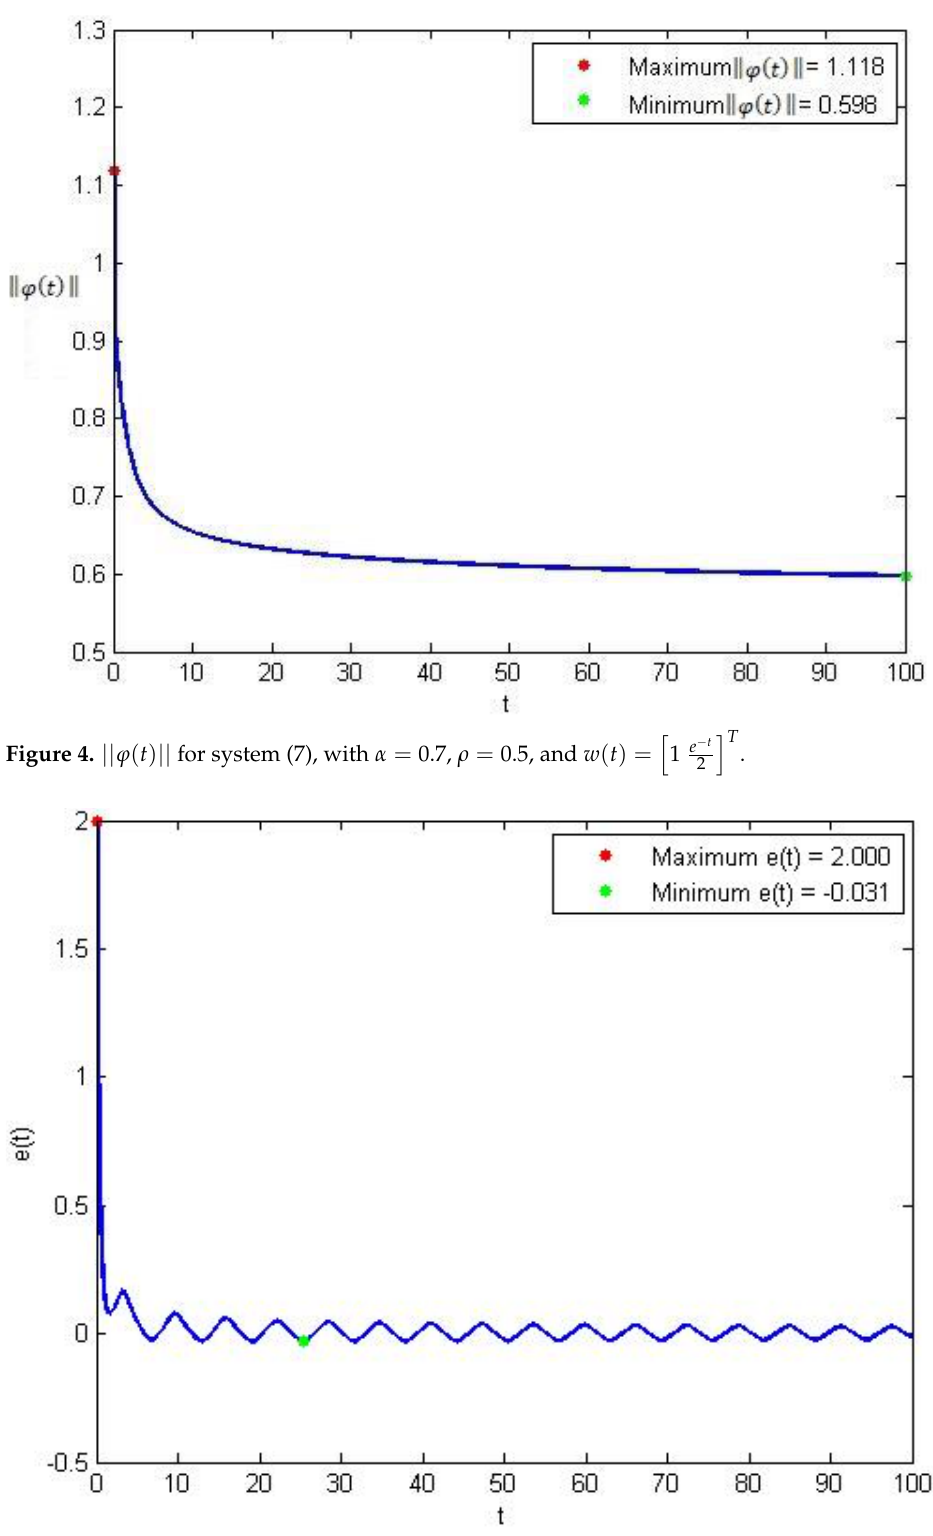
Figure 5. e ( t ) for system (7), with α = 0.7, ρ = 1.5, and w ( t ) = [ 2 sin ( t )] T Figure 5. 𝑒(𝑡) for system (7), with 𝛼 = 0.7 , 𝜌 = 1.5, and 𝑤(𝑡) = [2 𝑠𝑖𝑛(𝑡)] 𝑇 .